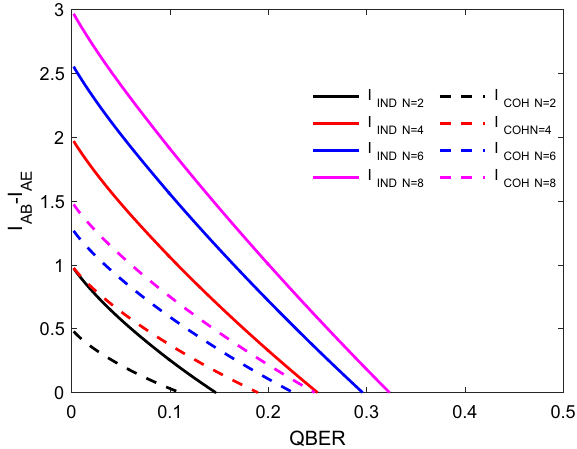
Fig. 2 Mutual information compared with different Hilbert space dimension. The mutual information thresholds between Alice and Bob/Eve in case of different Hilbert space dimensions and different Eve ’ s strategy. These curves are obtained in the case of two MUBs with individual and coherent